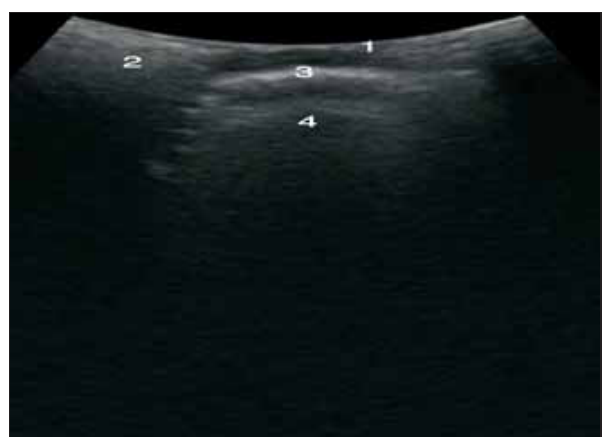
Figure-3: Ultrasonography of diseased goat's rumen imaged at left 12 ICS. Noticed that it was difficult to distinguish abdominal and ruminal wall. 1: ruminal wall, 2: ruminal content, 3: foreign body, 4: acoustic shadowing.